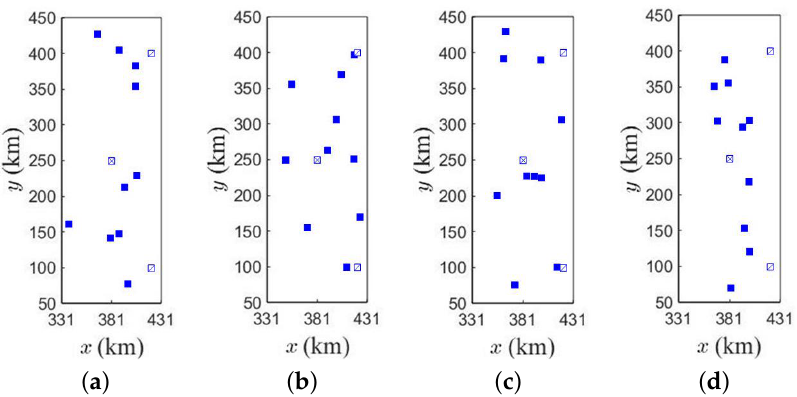
Figure 18. Optimal deployment plan of defense stations against slant attack formation, with kill probability set to 1, based on ( a ) ζ 1 ; ( b ) ζ 2 ; ( c ) ζ 3 ; ( d ) ζ 4 ; square with cross: major post, square with slash: minor post, blue square: defense